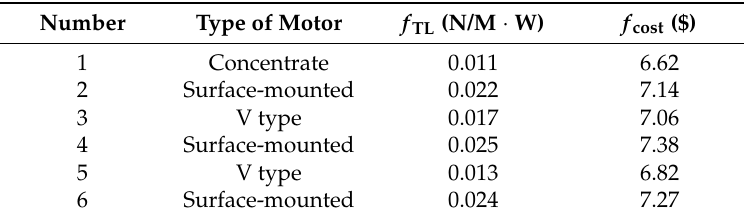
Figure 9. The Pareto Front of the multi-objective optimization (MOP). Table 7. Optimal solutions of the MOP.